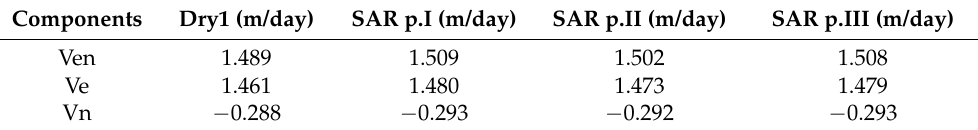
Table 4. Comparison between the horizontal velocity, and its components, of the DRY1 GNSS point, and the interpolated offsets of the three processed SAR pairs. Values are expressed in meters per day.